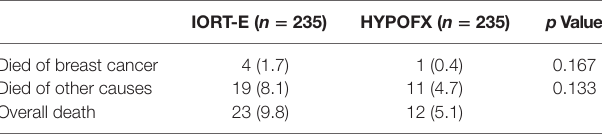
TaBle 3 | Mortality rate in intraoperative radiation therapy with an electron beam (IORT-E) group and in HYPOFX group.